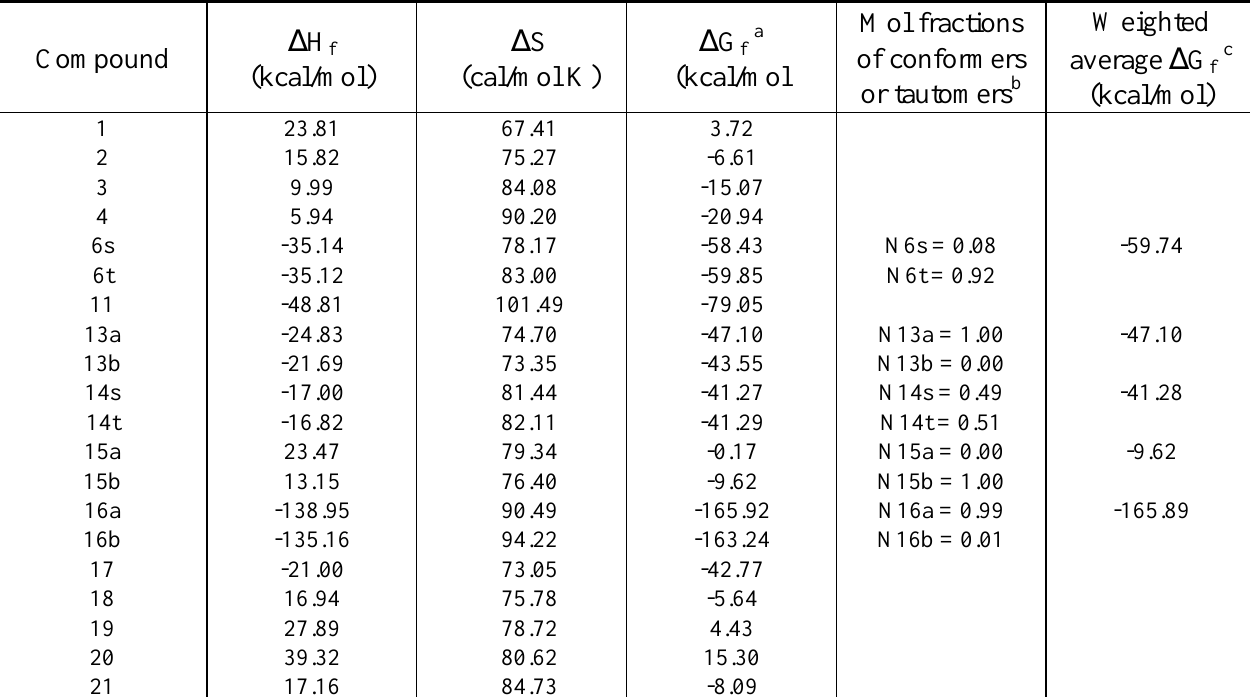
Table 1. The AM1 calculated thermodynamic properties of pyridine derivatives in aqueous solution ( e